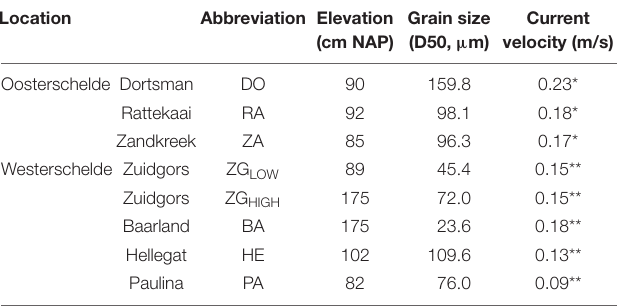
TABLE 1 | Study locations and their